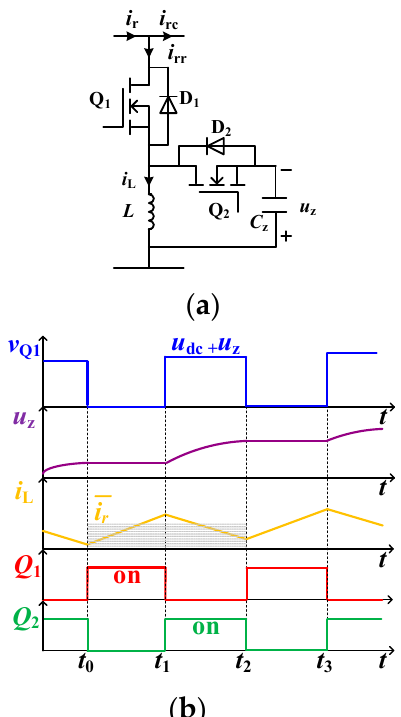
Figure 3. The buck-boost-type power decoupling circuit and the modal diagram in continuous current mode (CCM): ( a ) the buck-boost-type power decoupling topology; ( b ) the modal diagram in CCM.